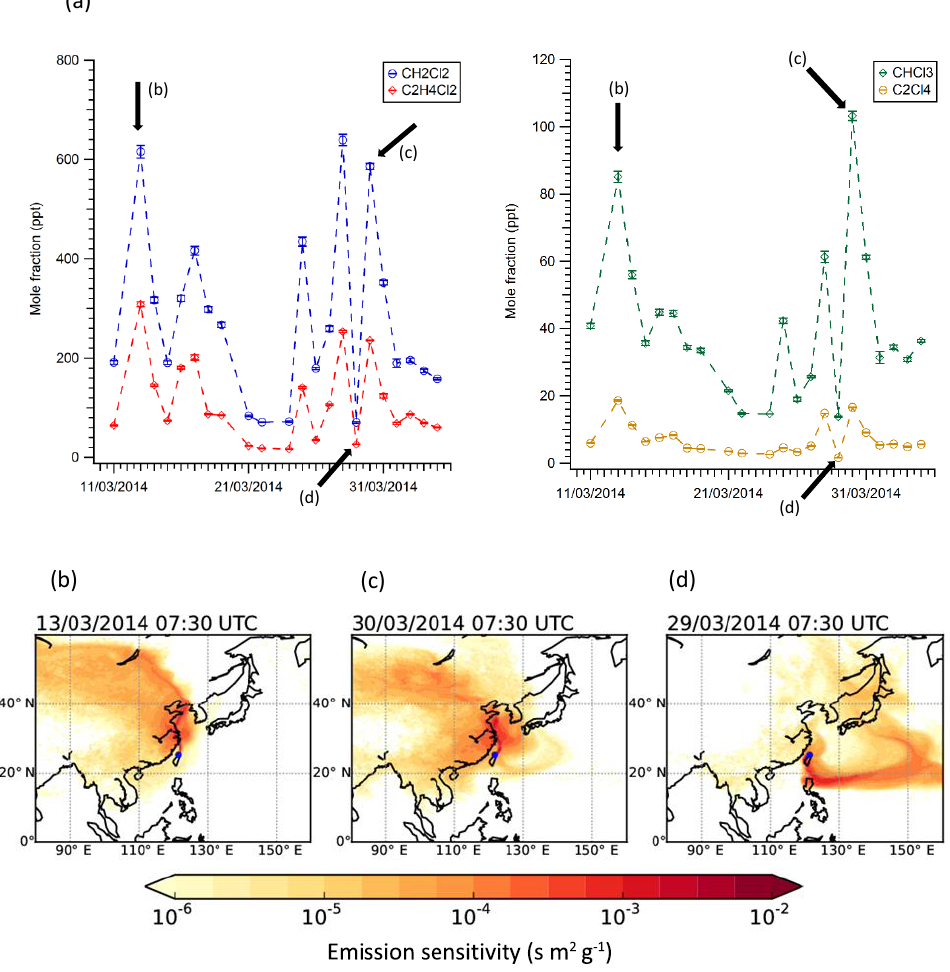
Figure 2. Upper panel (a) : Mole fractions (ppt) of the four chlorinated VSLSs in air samples collected at Cape Fuguei, Taiwan, in March/April 2014. The error bars are ± 1 standard deviation. The black arrows show the dates of the footprint maps shown below. Lower panel (b– d) : NAME footprint maps indicating the likely origin of the air sampled at Cape Fuguei. Panel ( b ), 13 March, and ( c ), 30 March, show examples where the observed VSLS levels are very high and suggest a strong influence from continental East Asia. Figure (d) is from 29 March where the influence of the mainland is much lower and the VSLS mole fractions are much closer to the expected background level. The location of Cape Fuguei is indicated with a blue circle (see also Fig.